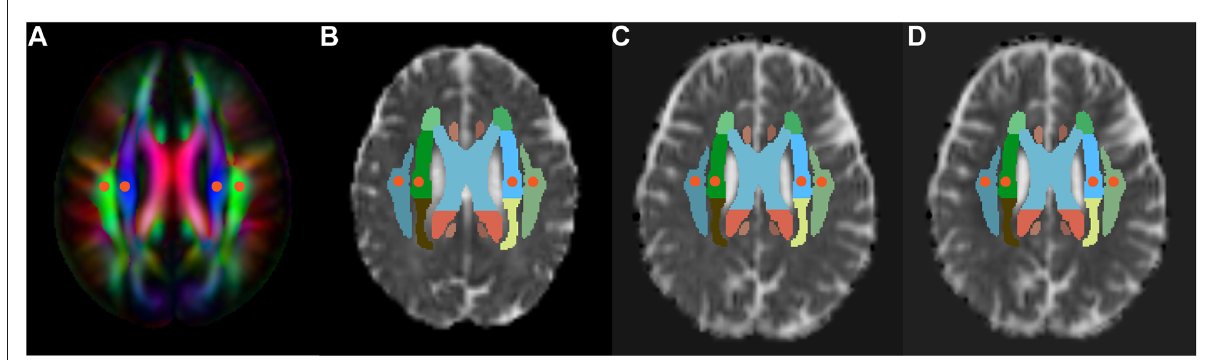
FIGURE1 Demonstration of ROI placement. The placement of the ROIs (red circles with a diameter of 5 mm) was determined on the color-coded standard fractional anisotropy (FA) atlas, and these ROIs were placed in the bilateral projection fibers (blue area) and association fibers (green area) in FA atlas, respectively (A) . Then, these ROIs were placed on the diffusivity maps (spatially normalized) in the direction of the x-axis (B) , y-axis (C) , and z-axis (D) .